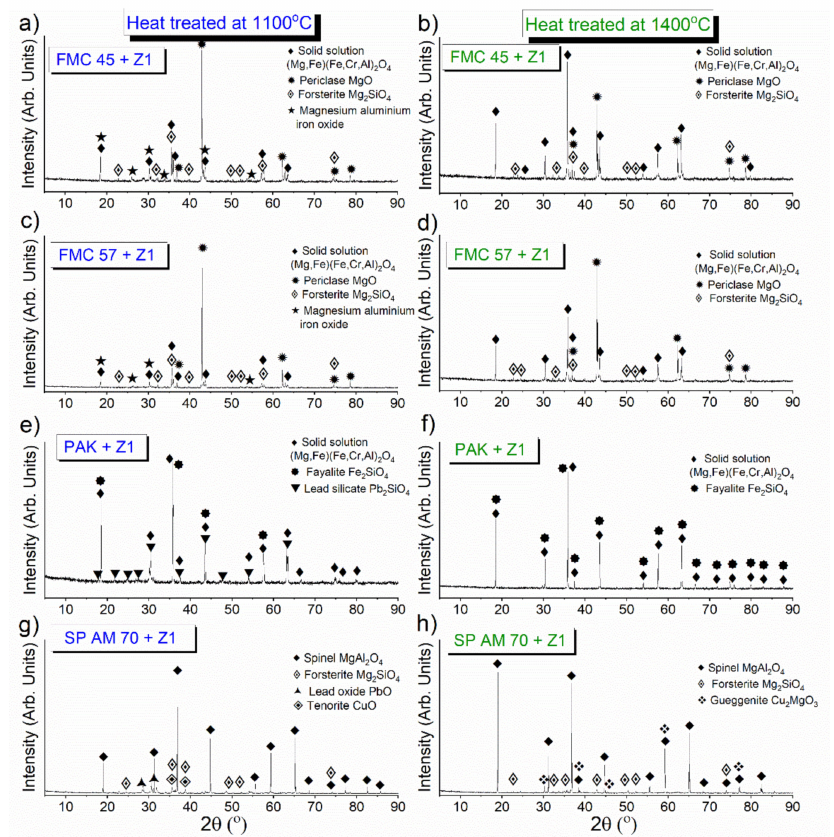
Figure 5. XRD patterns of raw material–slag mixtures after heating at 1100 ◦ C—( a ) FMC 45 + Z1, ( c ) FMC 57 + Z1, ( e ) PAK + Z1, ( g ) SP AM 70 + Z1 and 1400 ◦ C—( b ) FMC 45 + Z1, ( d ) FMC 57 + Z1, ( f ) PAK + Z1, ( h ) SP AM 70 +